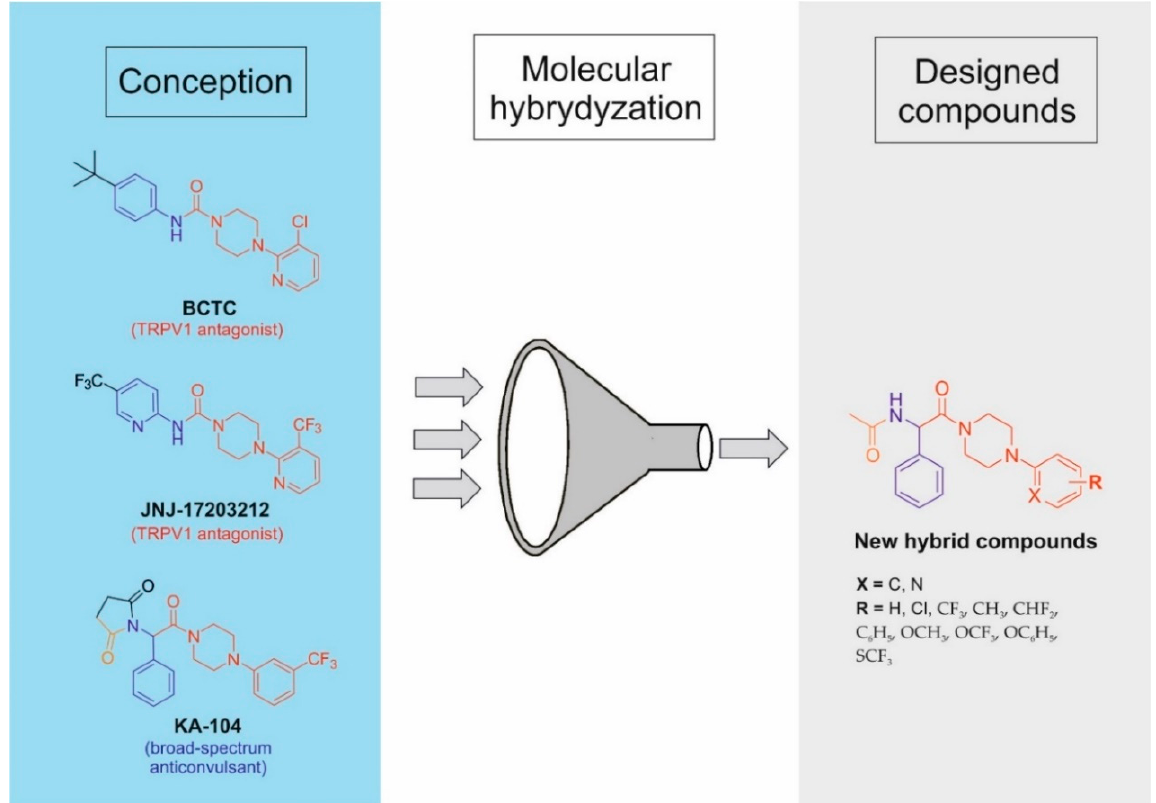
Figure 1. Design strategy and general structure of new hybrid molecules.